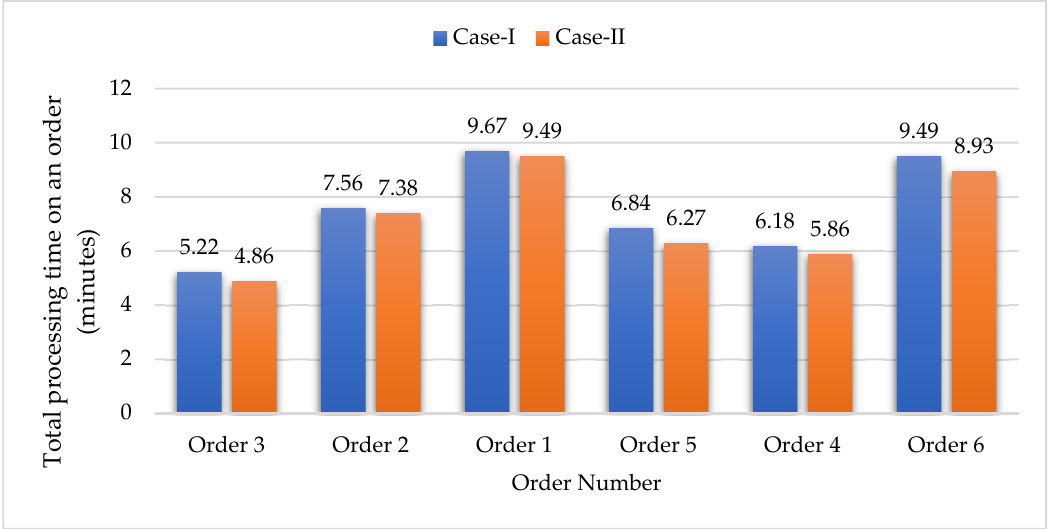
Figure 4. Comparison of the processing times for Case-I and Case-II using the EDD rule.